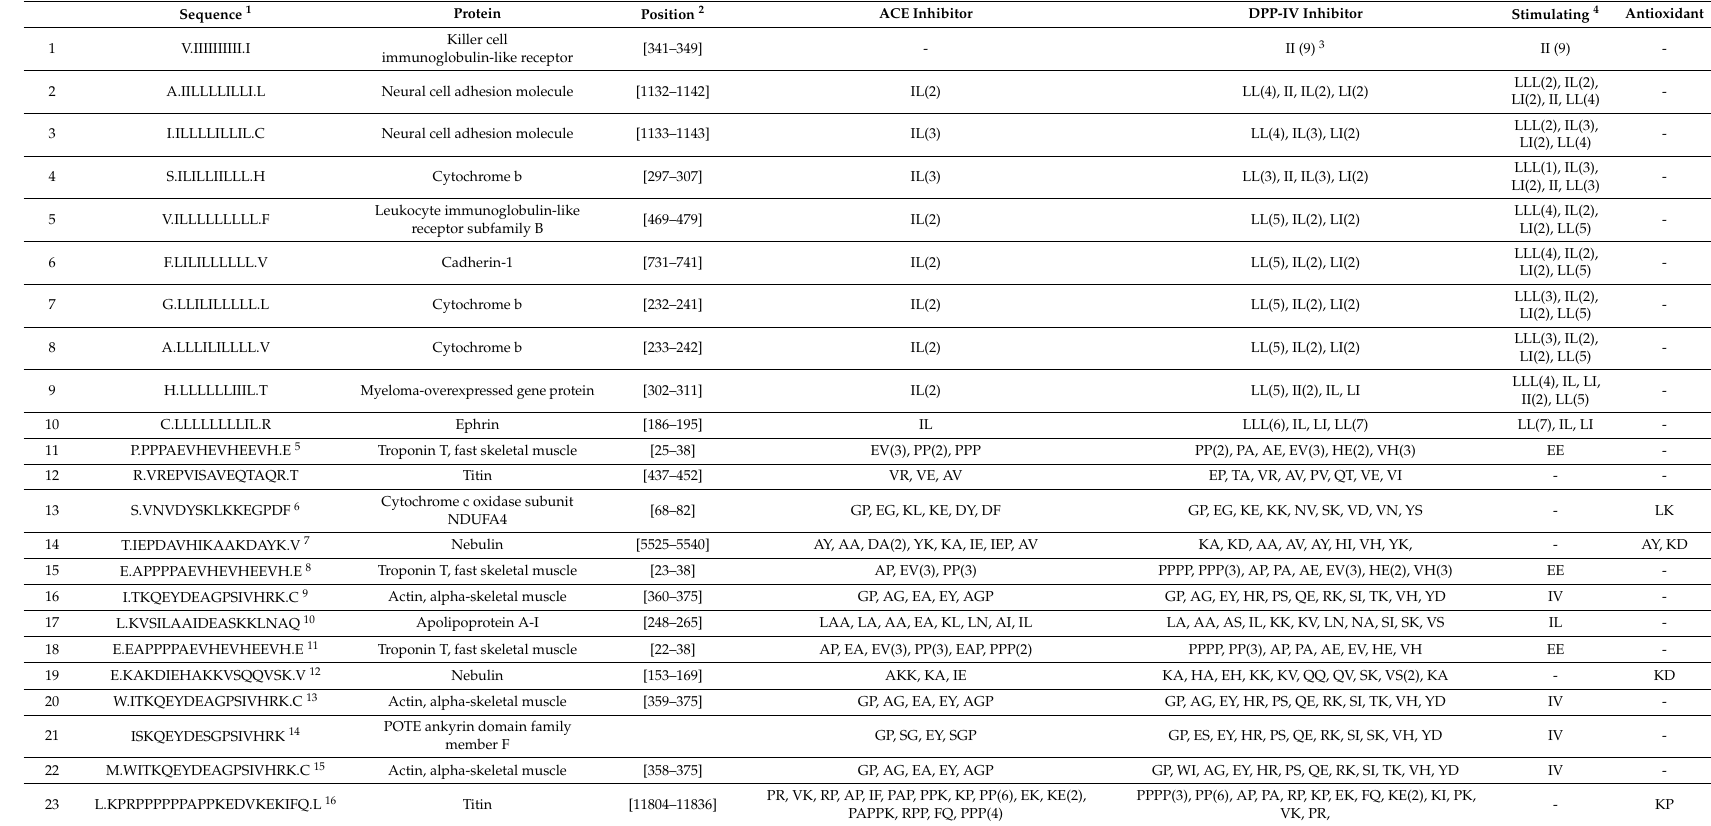
Table 3. List of peptide sequences common for organic